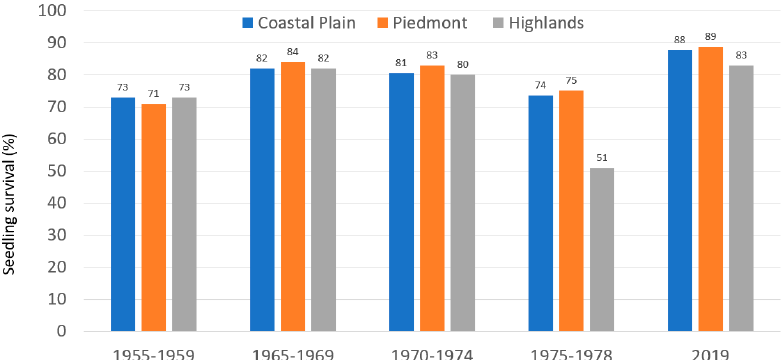
Figure 1. Early survival of pine seedlings reported for various periods in the southern United States. Adapted from [4–8]. Coastal Plain, Piedmont and Highland provinces were defined by Schultz